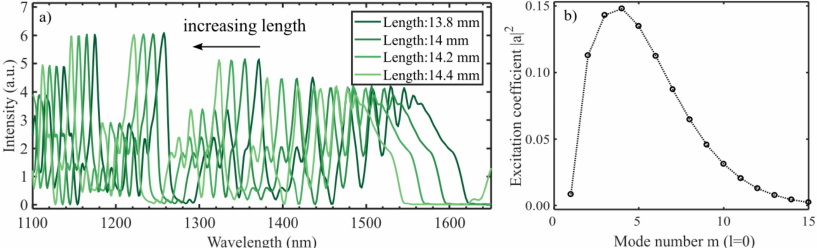
Figure 3. ( a ) Spectra of coreless interferometers with di ff erent lengths that have a perfect cleave. The spectrum sensitivity to the length of the interferometer is 60 nm / mm at around 1500 nm. ( b ) Excitation coe ffi cients for the radial modes ( l = 0 ) at the single mode fiber (SMF)-CL fiber interface. The excitation of the hybrid modes is calculated individually, however, only the sum of the square magnitude is plotted for each value of l .